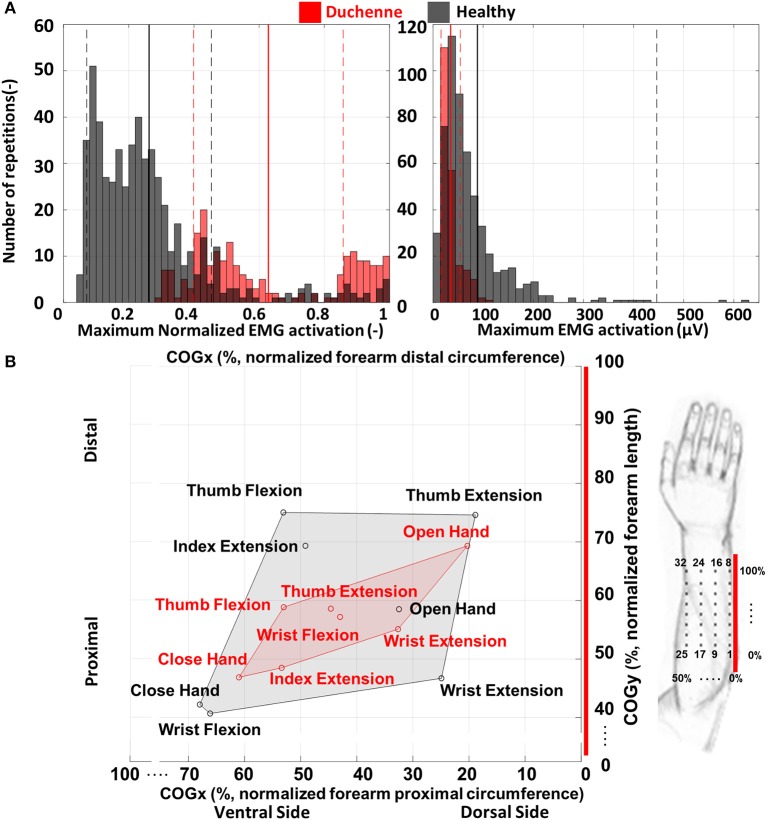
(A) The maximum normalized (left) and absolute (right) activation for each of the 10 repetitions of each gesture for all participants. Healthy participants generally performed the tasks with low levels of maximum normalized activation, while participants with Duchenne muscular dystrophy (DMD) showed higher levels of maximum normalized activation during the tasks. However, the maximum absolute activations were higher for the healthy participants. The full vertical lines represent the mean and the dashed the standard deviation. (B) The average center of gravity (COG) for the seven gestures for the healthy participants (black) and the participants with DMD (red). Healthy participants (gray shaded area) show on average a broader spatial distribution of the seven gestures than the participants with DMD (red shaded area). The red line represents the imaginary line that connects the lateral epicondyle and the styloid process of the ulna and was used as the border between the dorsal and ventral side of the forearm (see also Figure 1). The COG coordinates are normalized over the forearm circumference (COGx) and length (COGy).